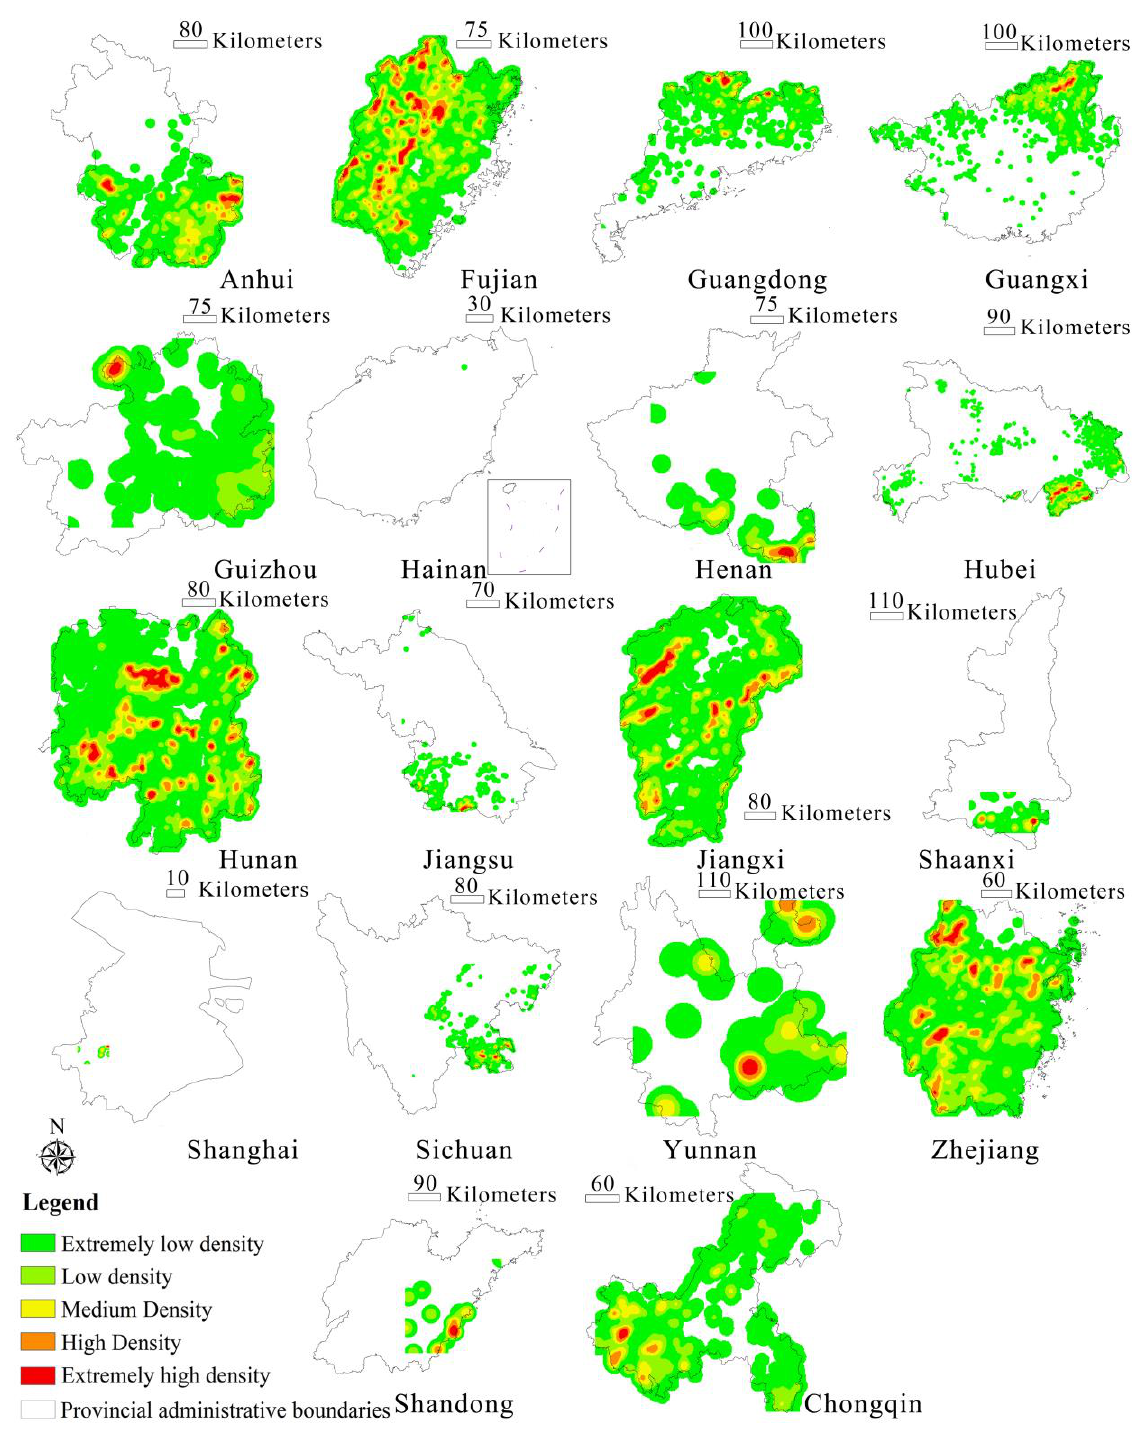
Figure 3. Spatial aggregations of moso bamboo forests by the province in 2010.